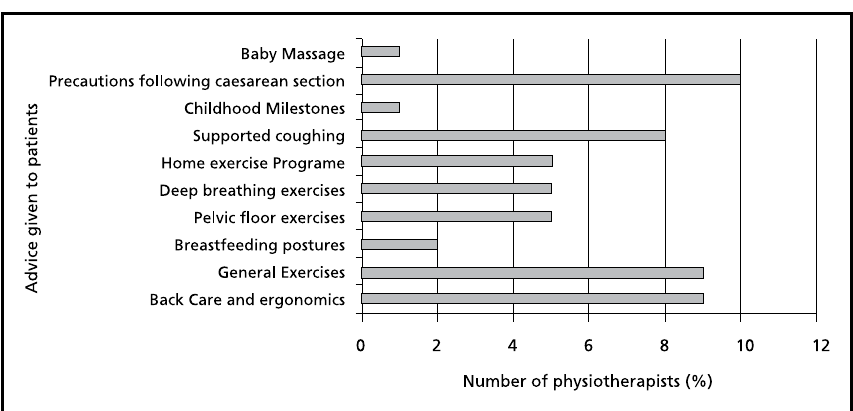
Figure 4: Discharge advice given to women